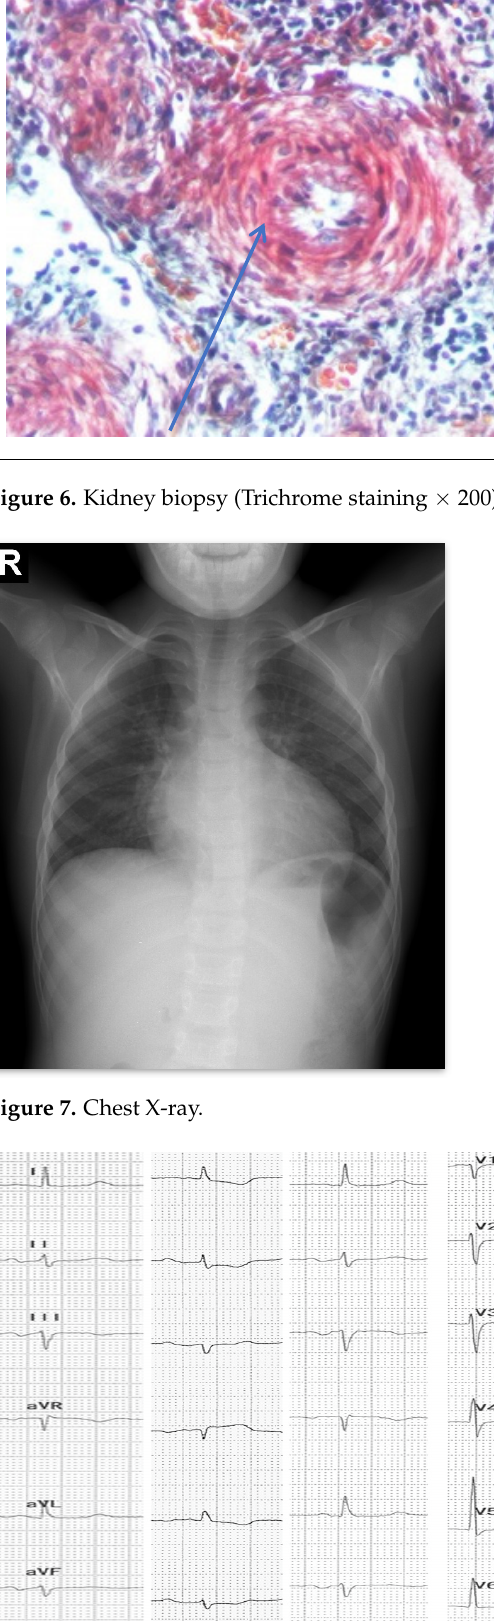
Figure 9. Echocardiography 4 chamber transthoracic apical view: echodense mitral and aortic valve, II-degree mitral regurgitation and I degree aortic regurgitation, pulmonary and tricuspid valve echodense, with I degree regurgitation. Left atrium and Left ventricle dilatation, normal kinetics, EF 70%, inferior vena cave not dilated, with inspiratory collapse, E/A > 2. Following the evaluations for the etiology of end stage renal disease (ESRD) we recommended abdominal ultrasound and CT scan. The abdominal ultrasound showed multiple homogenous hyperechoic nodular formations. The CT scan showed expansive renal formations replacing renal parenchyma, with a mass effect on it (Figure 2). We thought in that moment of a bilateral nephroblastoma, but the clinical and biological dates excluded it. There remained a possibility of extrapulmonary renal tuberculosis (due to his personal and family history). Even if the culture was negative for Koch Bacillus, while a value of 22 mm Palmer III—suggests tuberculin turn, the treatment was initiated according to the international guidelines [6] by the phthisiologist: triple combination of isoniazid, rifampicin and pyrazinamide in doses adjusted to his clearance, in the 7/7 scheme for 2 months, then isoniazid and rifampicin in the same doses 7/7 for another 7 months [6]. Two months after the initiation of the tuberculostatic treatment, a CT reevaluation was performed, which showed no changes in the renal formations, although